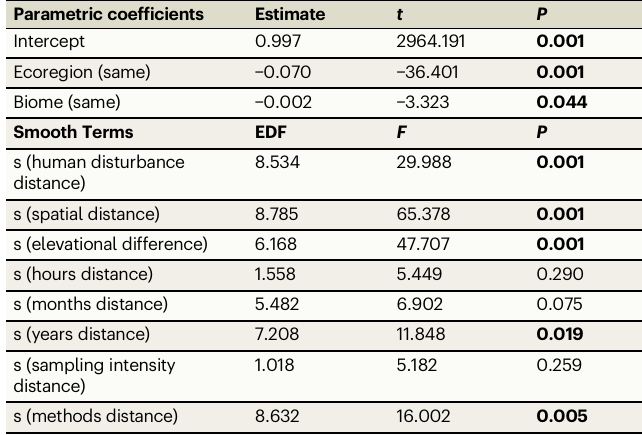
Table 1 | Multiple predictors of plant-frugivore interaction dissimilarity ( β WN ) Parametric coef fi cients